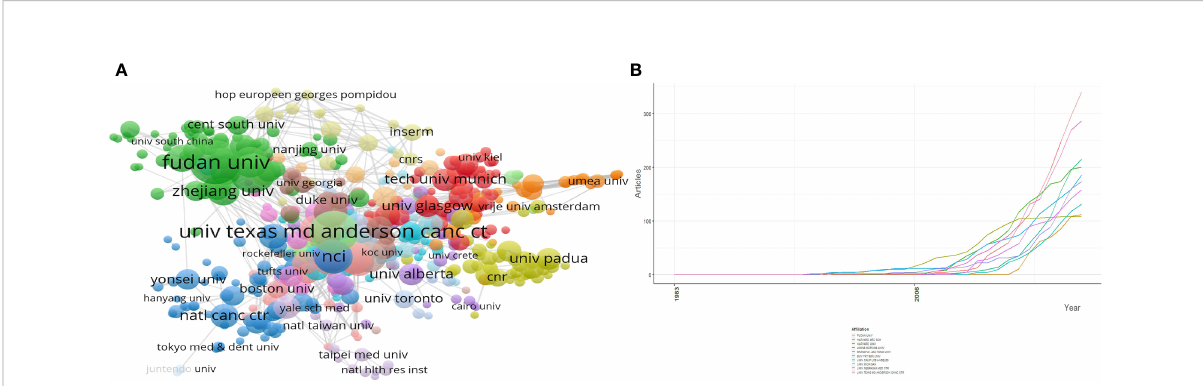
FIGURE 5 Analysis of institutions involved in pancreatic cancer metabolism. (A) Cluster analysis of cooperation among institutes; (B) Outputs trend of the top 10 most productive institutes.